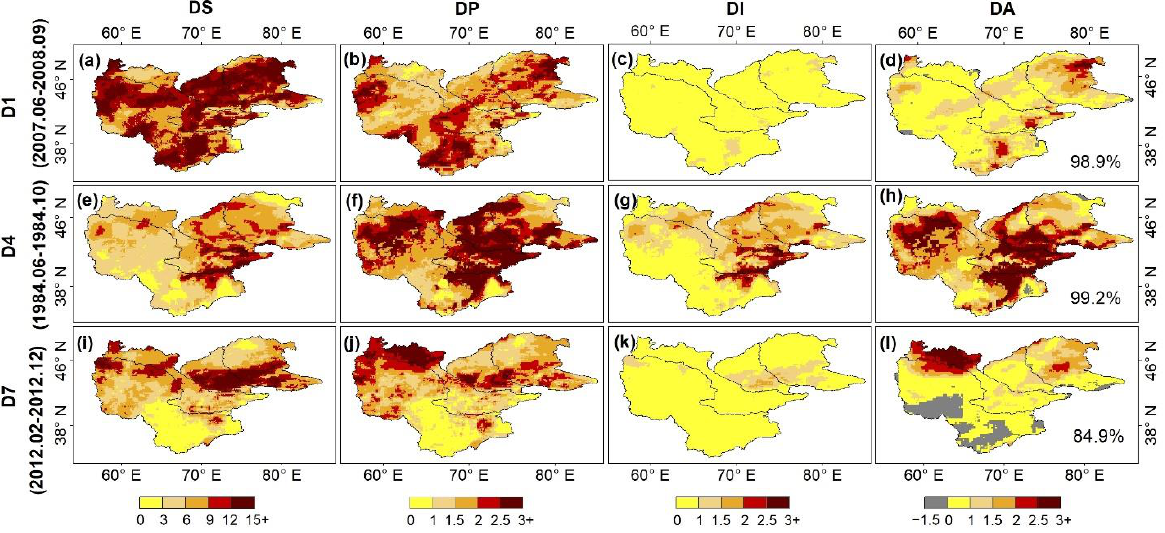
Figure 10. Spatial distribution of DS, DI, DP, and DA of the three drought events for ( a – d ) D1, ( e – h ) D4, ( i – l ) D7.